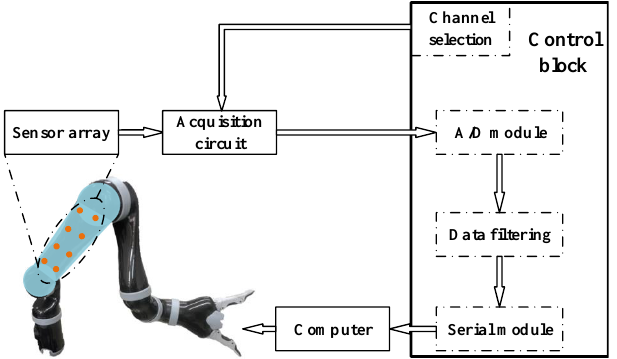
Figure 7. A schematic of the tactile acquisition system.